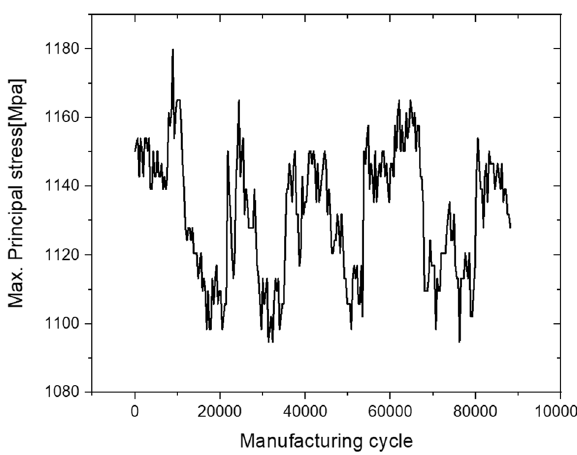
Figure 15. Real time maximum principal stress history.